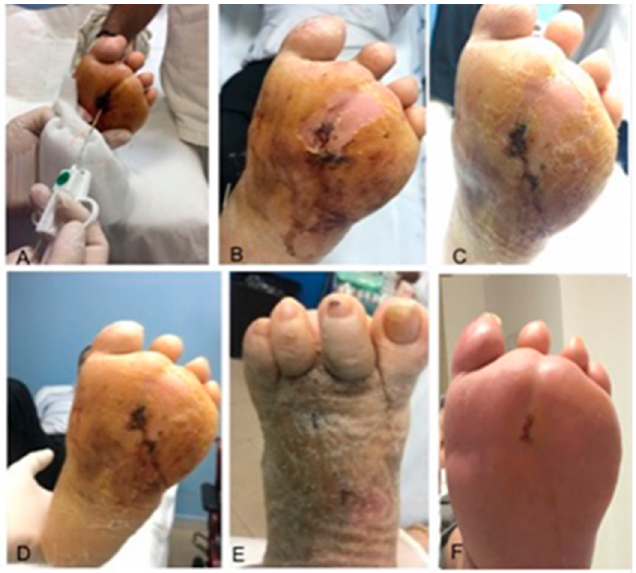
Figure 4. Lesion after treatment with IFWM at T 1 ( A ), T 2 ( B ), T 3 ( C ), T 4 ( D , E ), and the complete